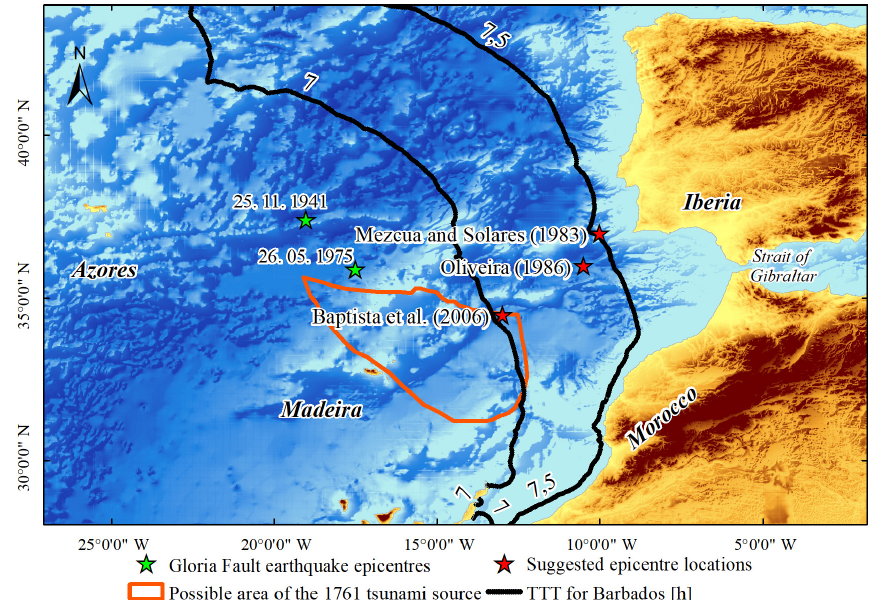
Figure 2. The red stars show the proposed source locations for the 1761 earthquake. The green stars present the epicentres of the two high- magnitude events in the Gloria Fault zone, and the black lines show the backward ray-tracing contours for the tsunami travel time (TTT) of 7–7.5h to Barbados. The limited orange area defines the results obtained using macroseismic analysis combined with backward ray tracing but discarding the TTT for Barbados by Baptista et al.